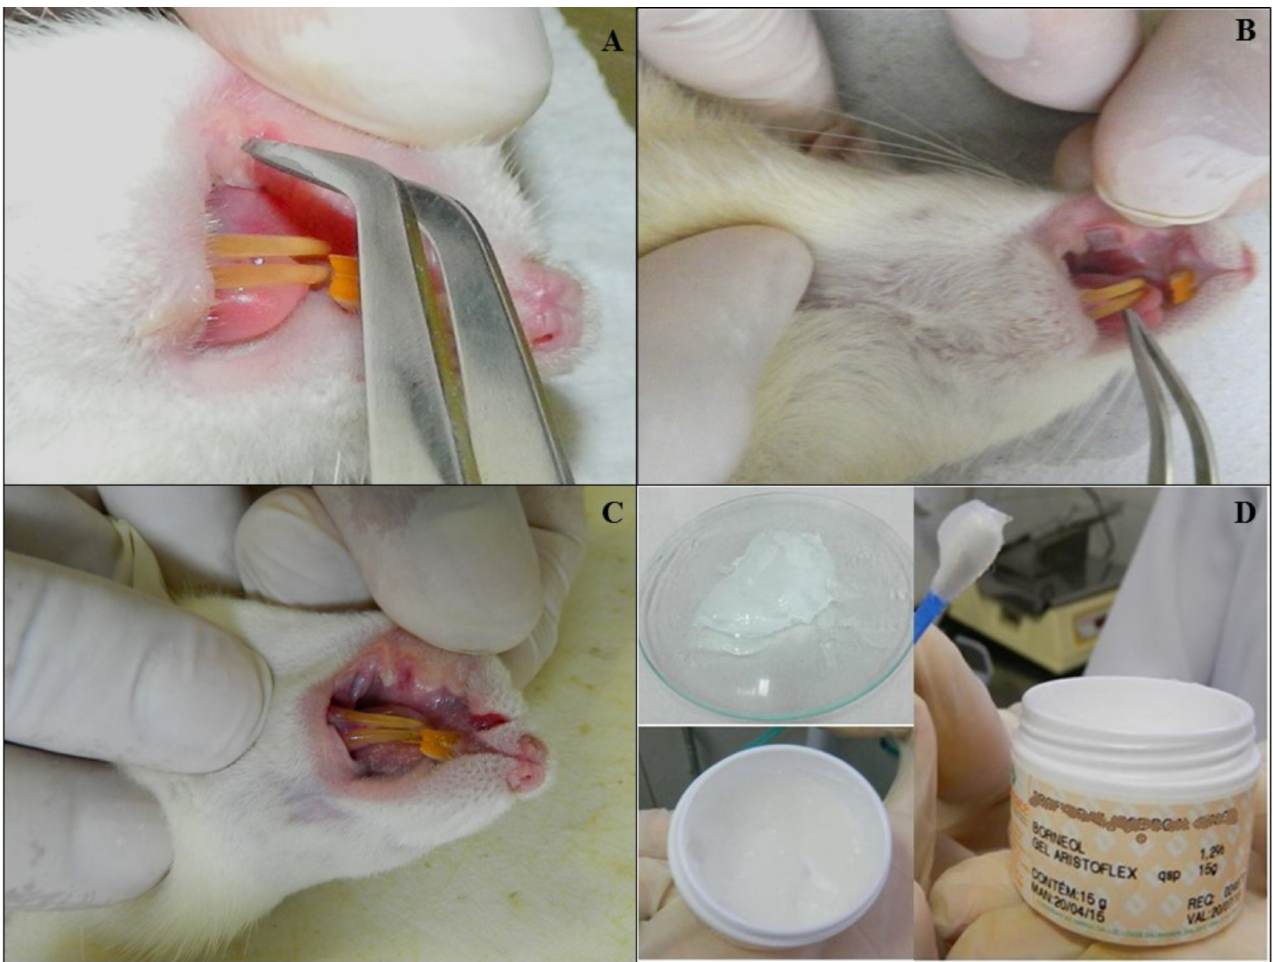
FIGURE 2 - Experimental procedure for testing. A. Placement of filter paper soaked in 50% acetic acid; B. Contact time with cheek mucosa of 60 s; C. Aspect of standardized lesion (9 mm 2 ) after filter paper removal; D. Appearance of gels used in